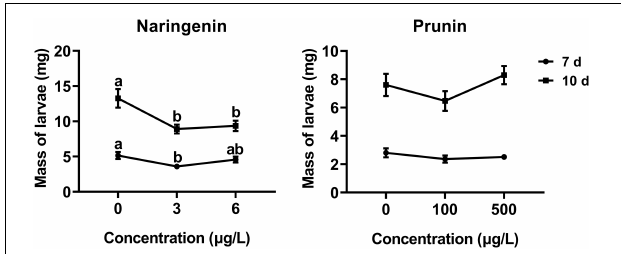
FIGURE 5 | Effects of naringenin and prunin on the weight gain of tea geometrid larvae. Data are presented as means ± SE ( n = 40), and different letters indicate significant differences among treatments [ P < 0.05, Turkey’s honest significant difference (HSD) post hoc